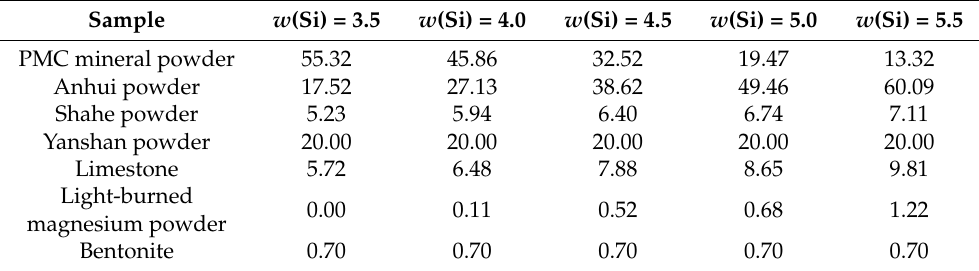
Table 5. Adjustment of Si content and ore blending scheme (%).